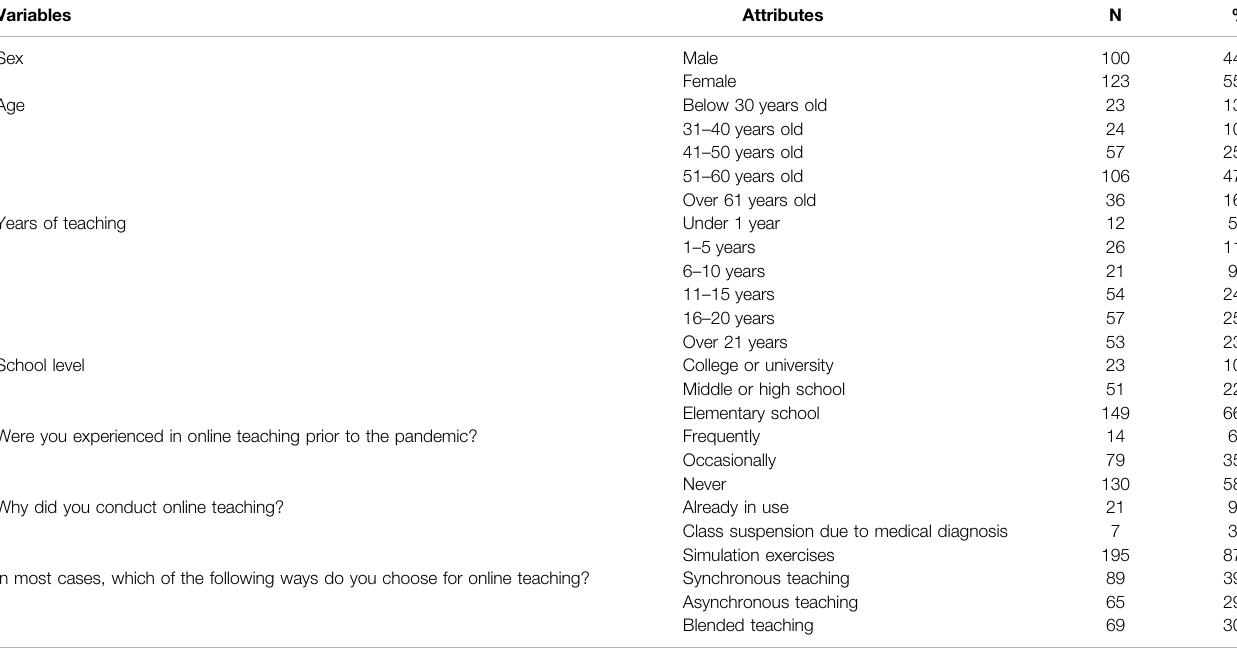
TABLE 1 | Participants ’ characteristics, including their online teaching experience. Variables